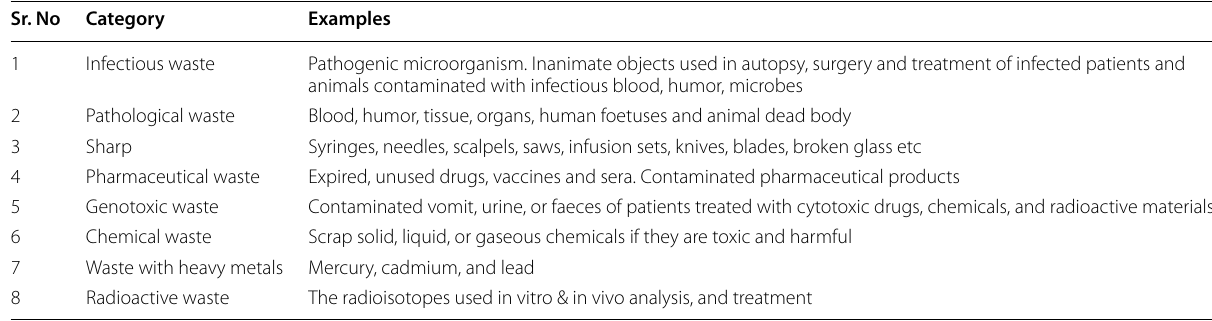
Table 2 Categories of biomedical waste Sr.